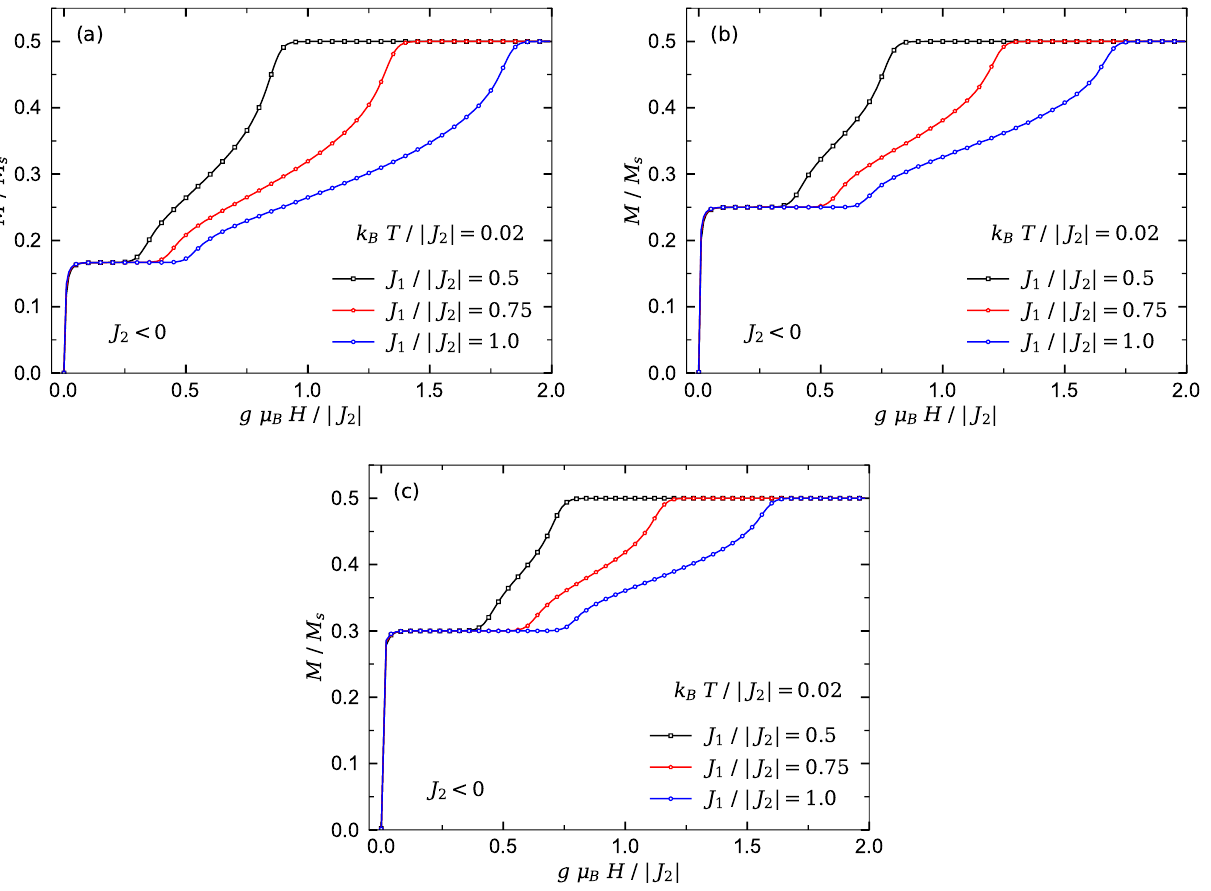
Figure 2. QMC results obtained for the magnetization curve of the three Heisenberg branched chains at low temperatures k B T / | J 2 | = 0.02 under the condition (I) where three different fixed values of the inter-chain interaction J 1 / | J 2 | = { 0.5,0.75,1.0 } are considered. ( a ) The magnetization of chain Υ 1